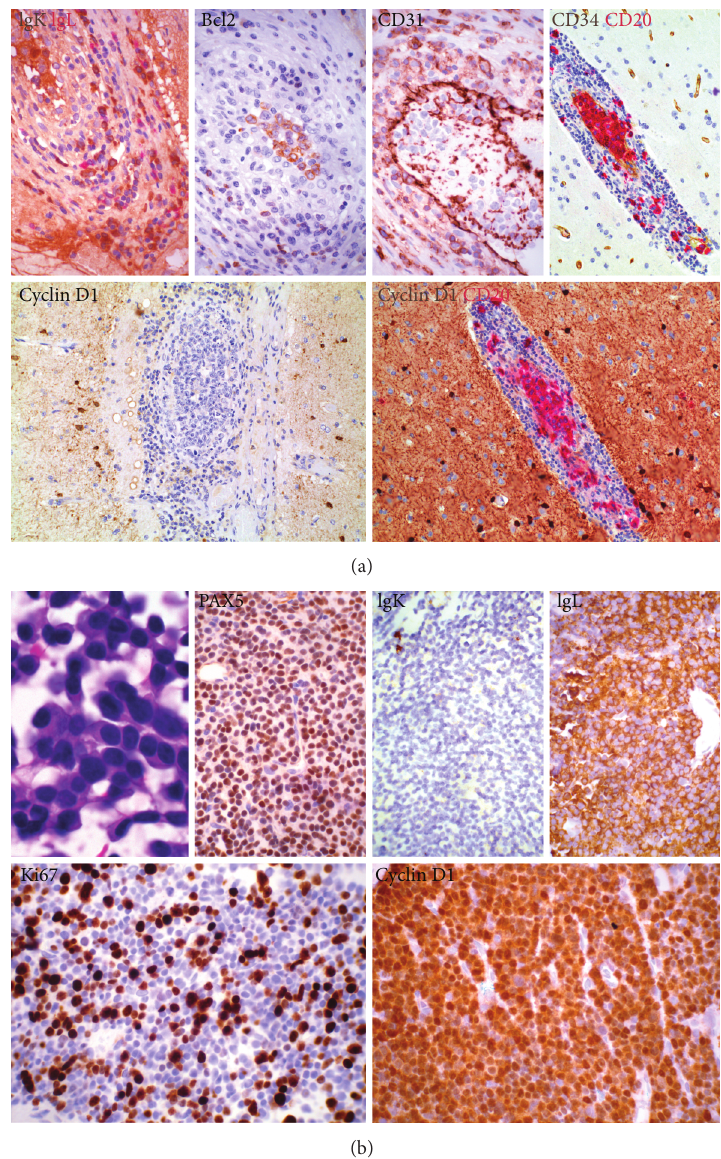
Figure 4: (a) Intravascular large B-cell lymphoma of brain. Neoplastic cells express bcl2 but lack cyclin D1 expression. In situ hybridization shows polytypic immunoglobulin light chain expression in the perivascular reactive plasma cells but not within intravascular neoplastic B cells. (b) Spinal plasma cell neoplasm. Apart from expression of CD138, the spinal plasma cell neoplasm displays expression of PAX5 and cyclin D1 but not CD56. In situ hybridization confirms lambda immunoglobulin light chain